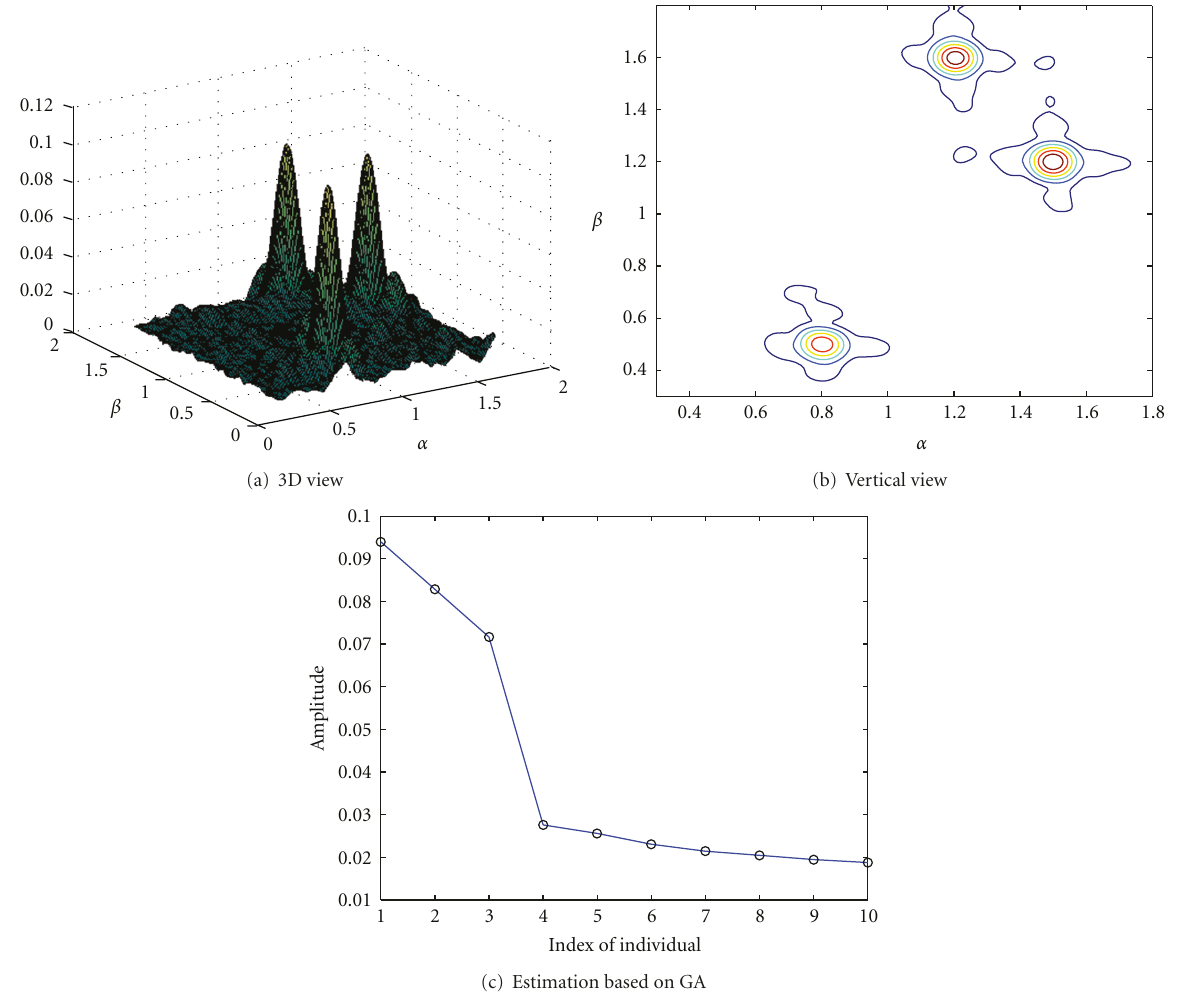
(cid:18) M α , β ) | of (7), e ( m , n ) is i.i.d white exponential noise, SNR = Figure 4: | 4 x (